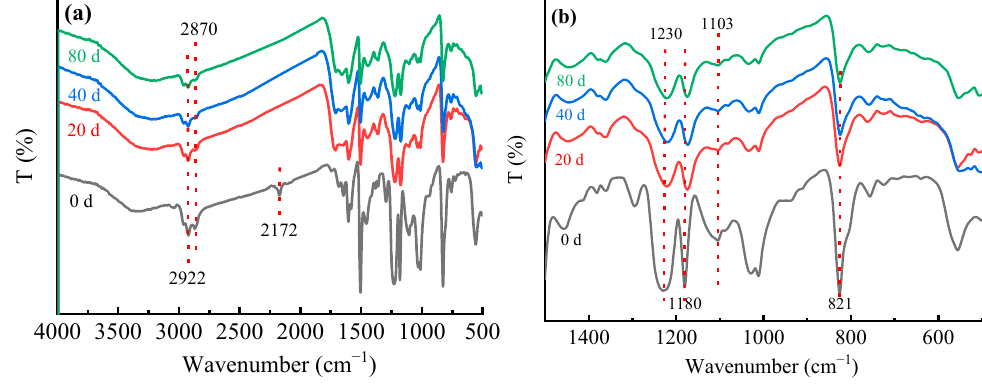
Figure 11. The FTIR spectra of the CFRP before and after aging: ( a ) full spectrum; ( b ) fingerprint region.